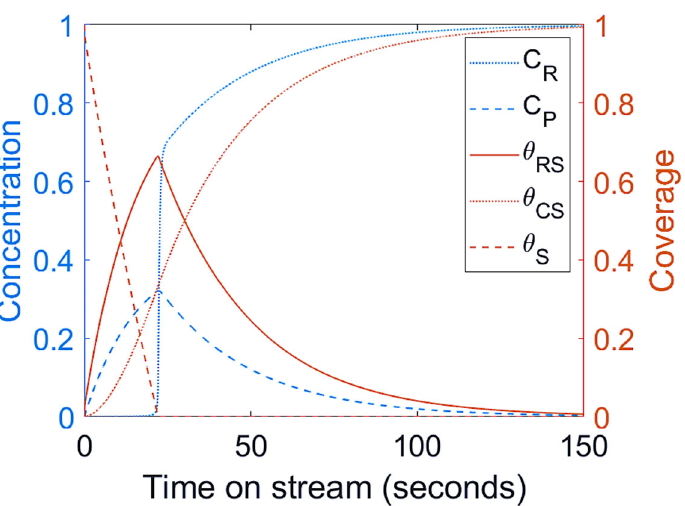
Figure 1. Estimated reactant and product concentration pro fi les ( left axis ) and surface species coverages ( right axis ) with respect to time for Mechanism I.